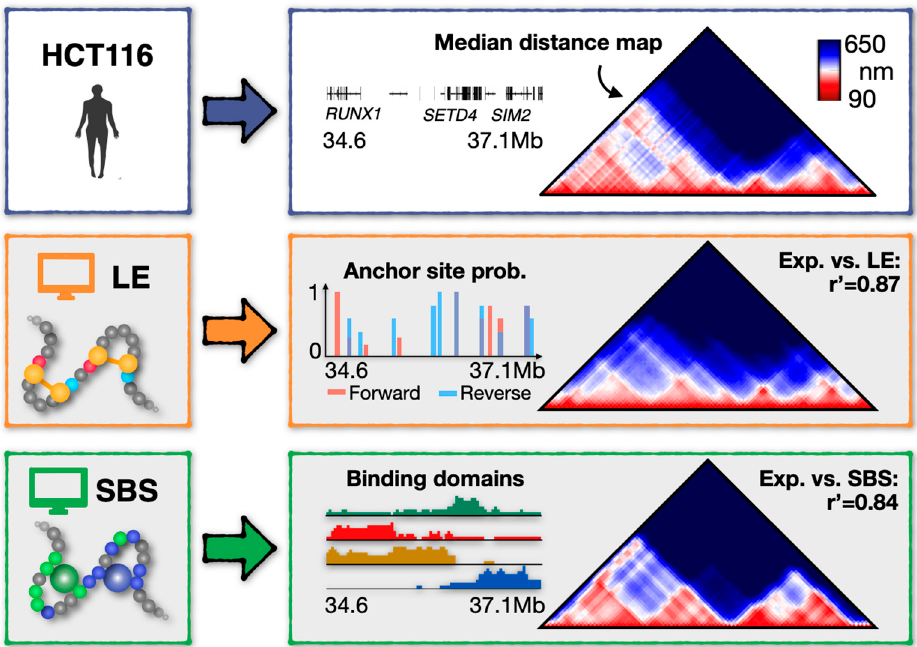
Figure 2. Loop extrusion ( LE) and Strings and Binders (SBS) models of a 2.5 Mb wide chromatin locus in human HCT116. The experimental median distance matrix of the locus (top) [13] is consistently recapitulated by the LE (middle) and SBS (bottom) models, as highlighted by their high distance-corrected correlation coefficients (respectively, r’ = 0.87 and r’ = 0.84), indicating that both mechanisms significantly capture the spatial conformation of the locus at the ensemble-average level. Adapted from [64,65].